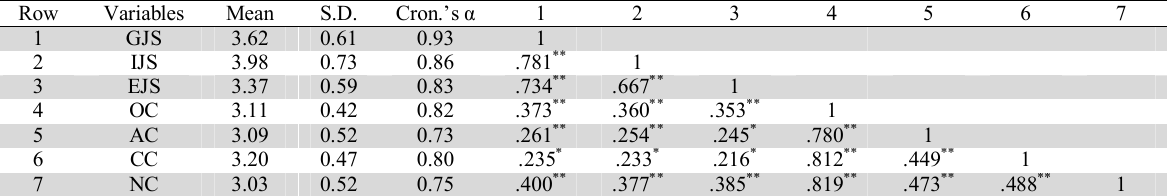
The correlation matrix of job satisfaction, organizational commitment, and their